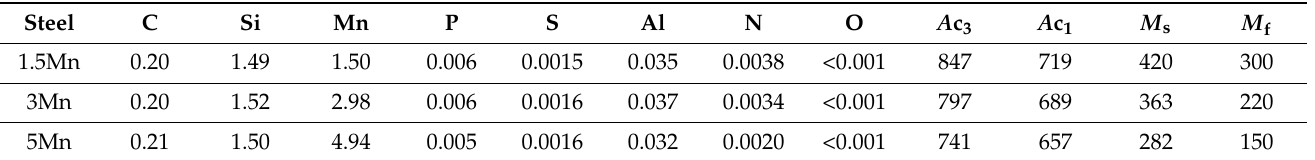
Table 1. Chemical composition (mass%) and various transformation temperatures ( A c 3 , A c 1 , M s , and M f in ◦ C) of steels